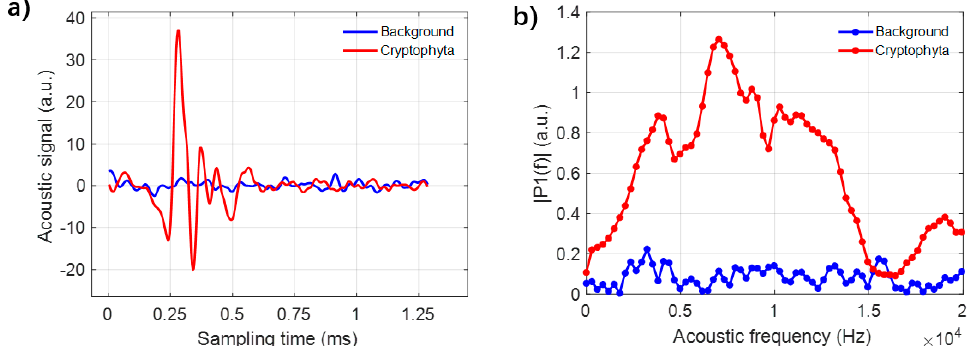
Figure 4. ( a ) The acoustic signals of Cryptophyta and the background; ( b ) The fast Fourier transform (FFT) spectra of Cryptophyta and the background signal. The signals of Euglena and Cryptophyta samples are measured and compared with each other. After measuring the suspended samples for about ten minutes, a series of the acoustic and optical signals are simultaneously recorded and respectively analyzed. The acoustic and optical features are analyzed and used to characterize the samples, including the acoustic frequency, fluorescence and integrated polarization parameters. Then, their probability distributions of these two categories were counted and are shown in Figure 5.